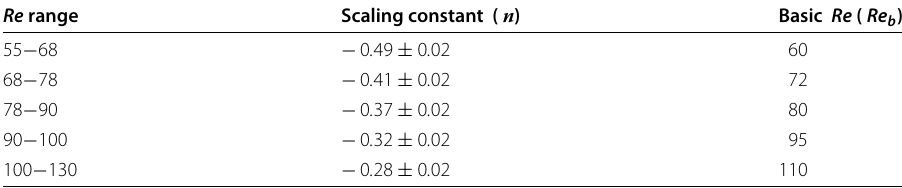
Table1 Scaling constant and base Re b for different range of Re s Re range Scaling constant ( n ) Basic Re ( Re b )